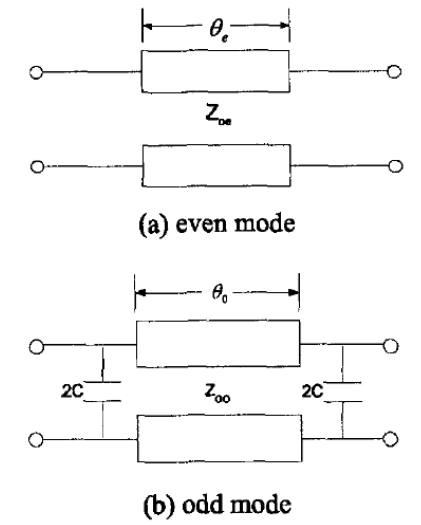
Figure 2. The equivalent circuit of even (a) and odd mode (b) [18]